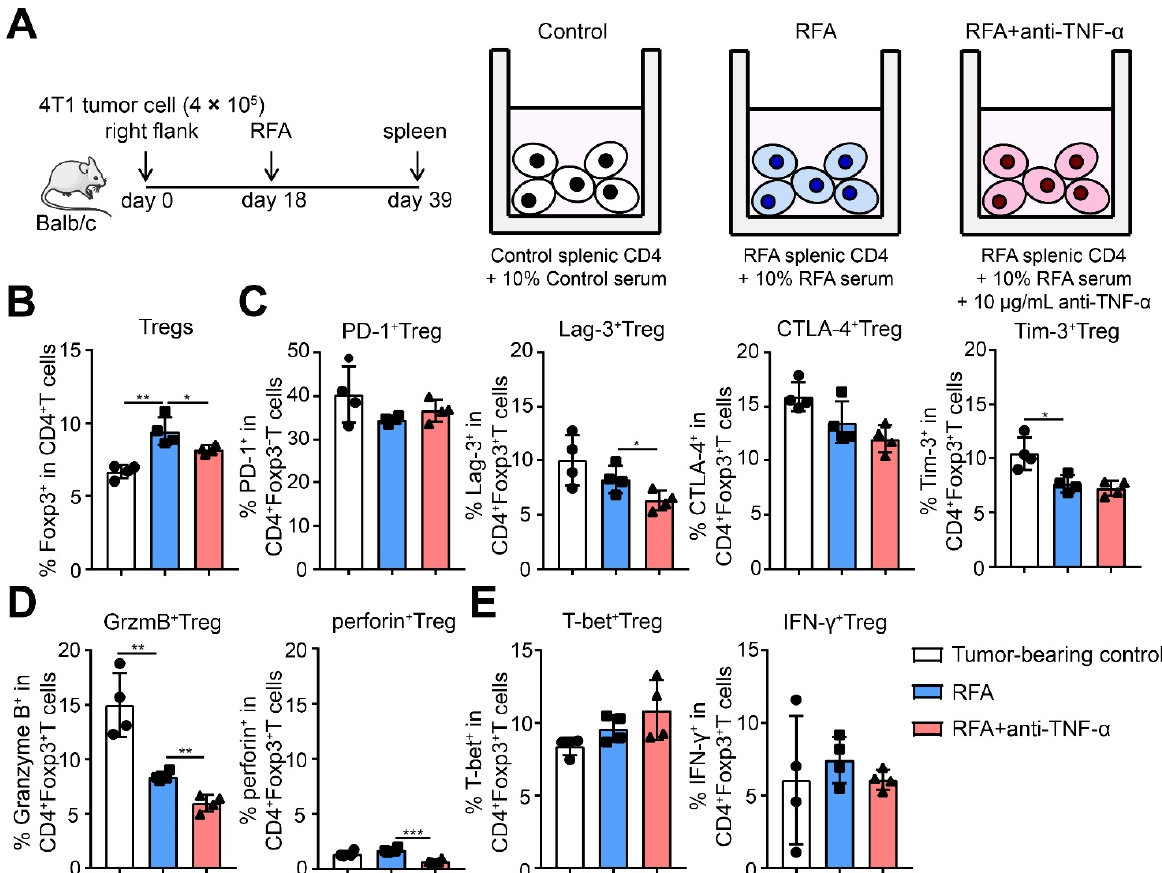
Figure 8. TNF- α neutralization after RFA treatment inhibited Treg function and suppressed tumor metastasis, as well as promoted the long-term survival of mice. ( A ) Schematic of experimental design. Splenic CD4 + T cells were separated from tumor-bearing control (39 days after inoculation) or RFA treated mice (21 days after treatment) and cultured in vitro for 24 h. The serum from tumor-bearing or RFA treated mice was added in corresponding group. An anti-TNF- α antibody was added in the concentration of 10 μ g/mL. The proportion of Tregs ( B ), the expression of inhibitory checkpoints ( C ), the expression of suppressive cytokines ( D ), and the expression of T-bet, IFN- γ of Tregs ( E ) were detected by flow cytometry. n = 4 for each group. * p < 0.05, ** p < 0.01, *** p < 0.001.